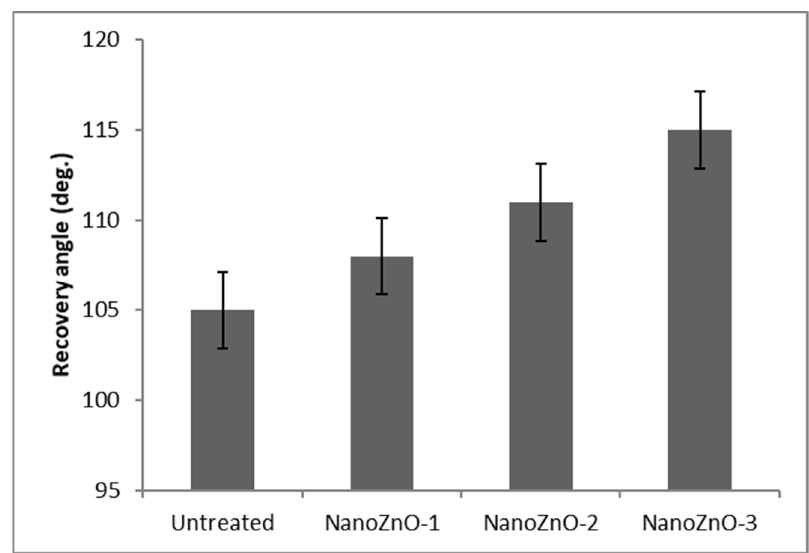
Figure 7. Crease recovery of untreated and ZnO nano-treated fabric.